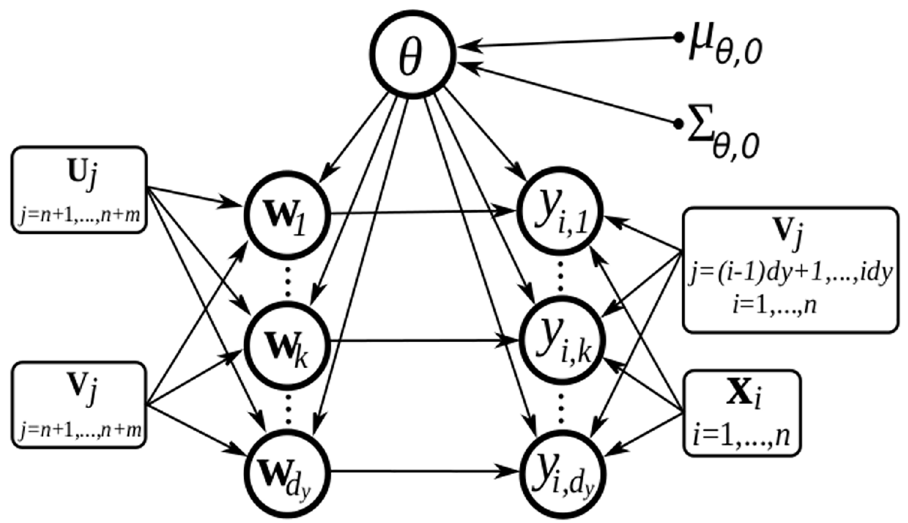
Fig 1. Graphical model of GMEP in which dependences between variables are shown by using circles for random variables,rectangles for known variables and dots for fixed